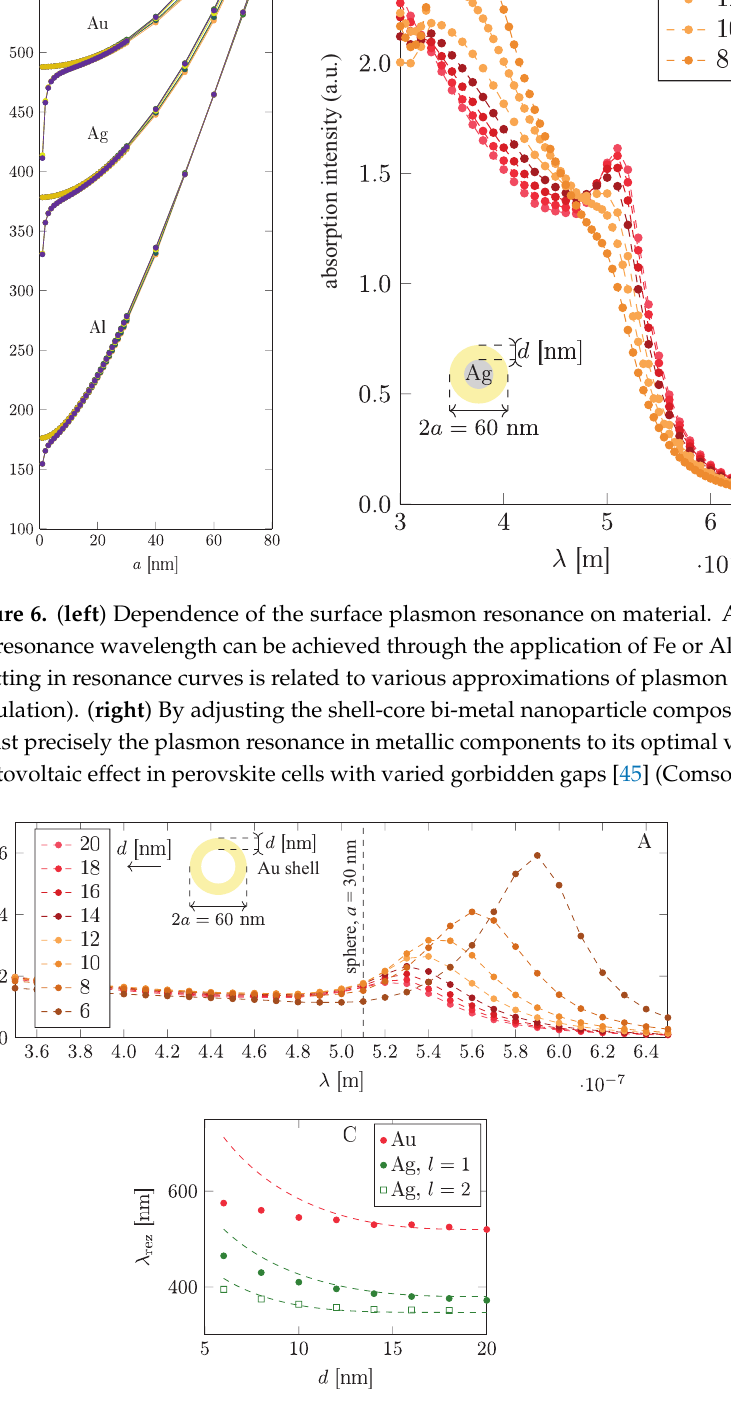
Figure 8. Dependence of the dipole surface plasmon resonance in the single shell-type nanoparticle Figure 7. The dipole surface plasmon resonance in a single shell-type nanoparticle versus its geometry. versus its geometry. In lower panel, l = 1 and l = 2 for Ag denote the dipole and quadrupole mode, In lower panel, l = 1 and l = 2 for Ag denote the dipole and quadrupole modes, respectively [45] respectively [44] (Comsol simulation). (Comsol